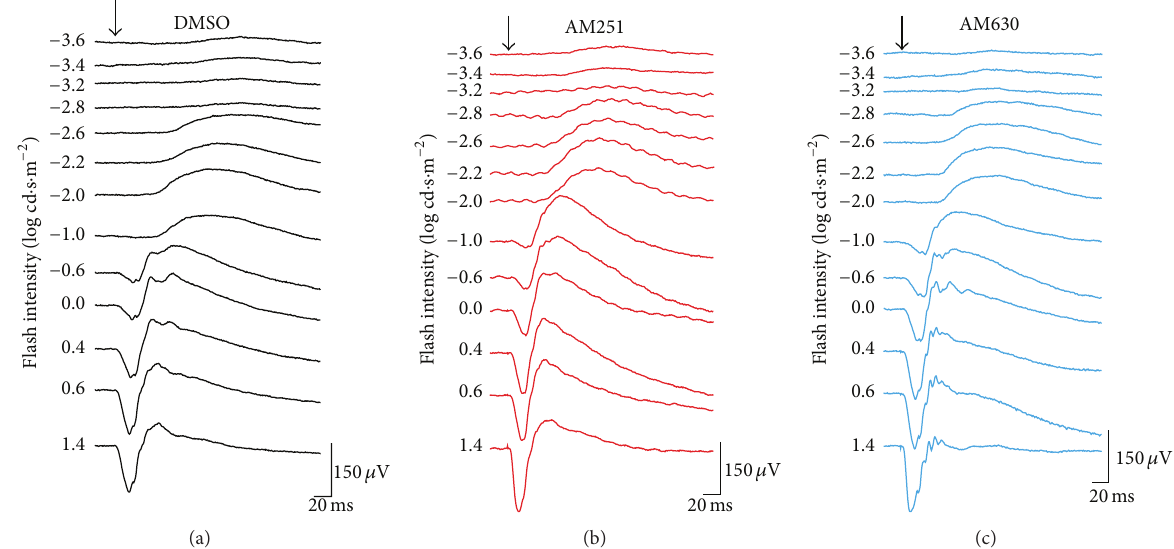
Figure 5: Raw scotopic ERGs in the different drug injection groups. Representative ERGs recorded after intravitreal injection of DMSO (a), AM251 (b), or AM630 (c). ERG recordings of each treated animal were established by presenting progressively brighter flashes (top to bottom). Horizontal calibration, 20 ms; vertical calibration, 75 𝜇